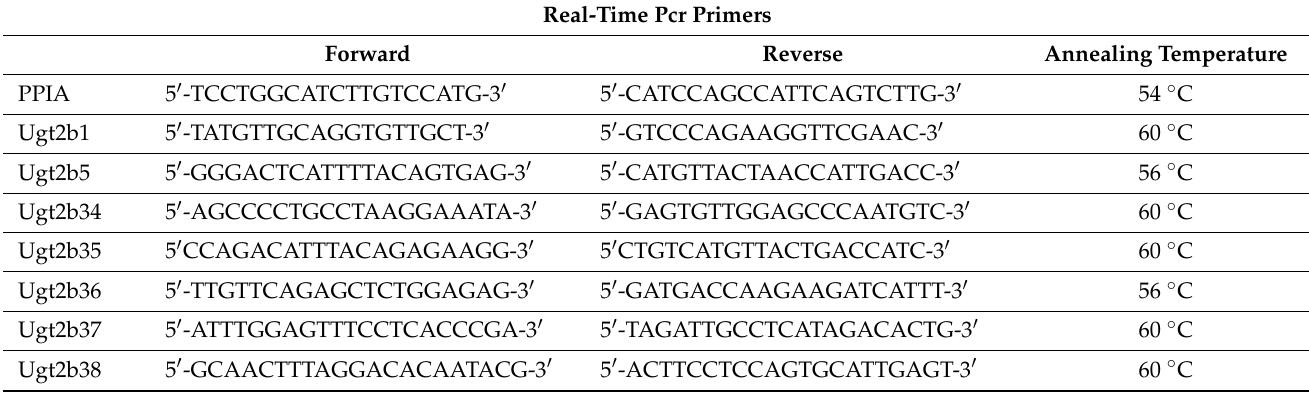
Table 1. Primer sequences for real time PCR analyses of mouse